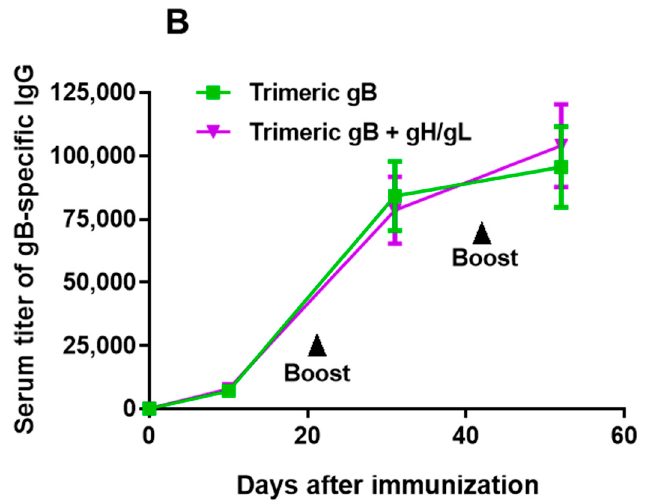
Figure 1. Immunization of rabbits with Epstein–Barr virus (EBV) gH/gL or trimeric gB recombinant protein induced high serum titers of antigen-specific IgG, without interference when EBV gH/gL and trimeric gB were used in combination. Groups of 12–15-week-old rabbits ( n = 5), were subcutaneously immunized with 25 µ g of recombinant EBV gH/gL, EBV trimeric gB or the combination of EBV gH/gL and trimeric gB (25 µ g each) adjuvanted with alum + CpG-ODN, then boosted on days 21 and 42. Serum samples were obtained 10 days following each immunization, and on day 52 for measurement of serum titers of antigen-specific IgG by ELISA. ( A ) Serum titers of gH/gL-specific IgG. ( B ) Serum titers of gB-specific IgG.